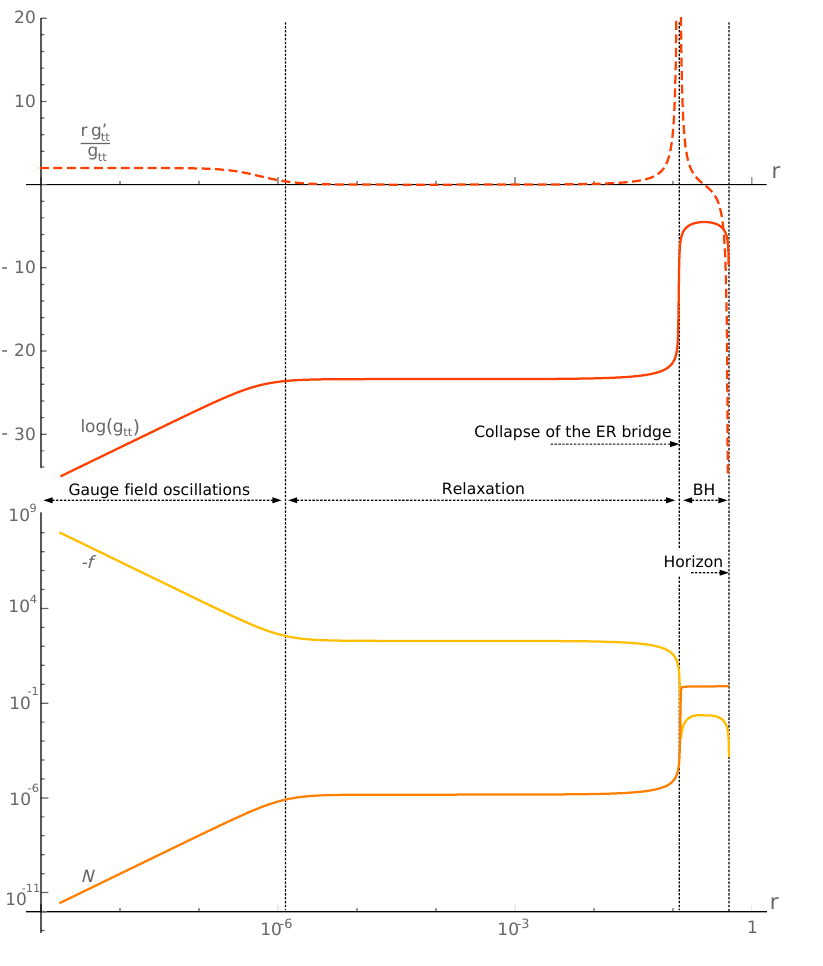
Figure 2 . Different dynamical epochs inside the horizon. Top: profiles for log g tt and rg 0 Bottom: profiles for N and − f . This plot corresponds to q = 1 , α = 2 , m = 1 , h 0 . 828 , h 0 = 1 . 118 , φ = 0 . 1931 , r = 0 . 72 . h h h